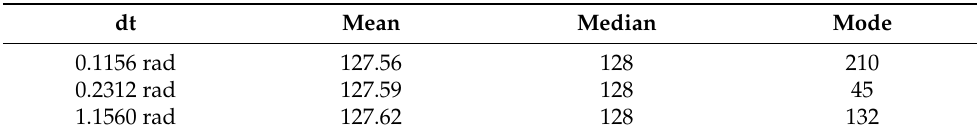
Table 4. Statistics data of Figure 8.